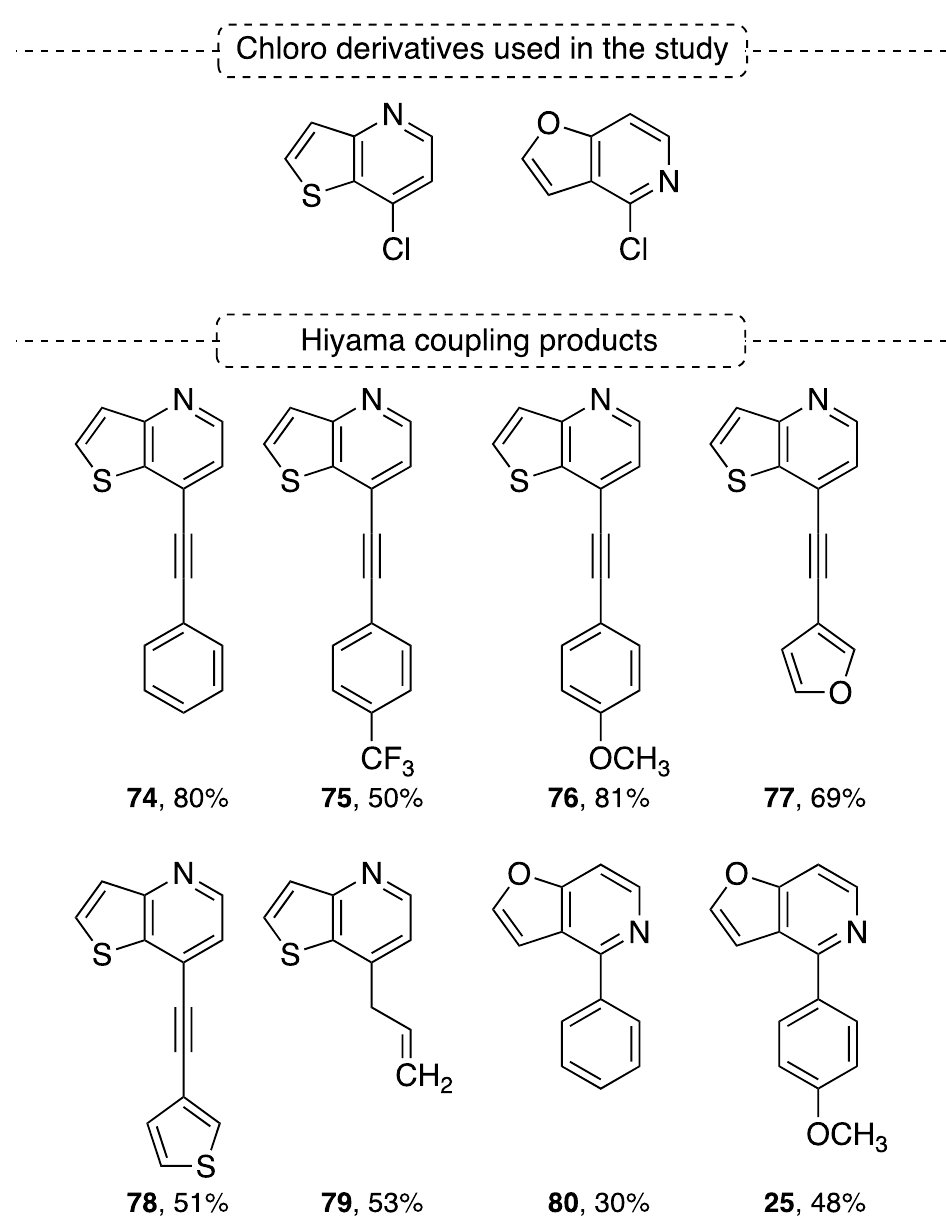
Figure 9. Hiyama coupling products in eucalyptol [151].